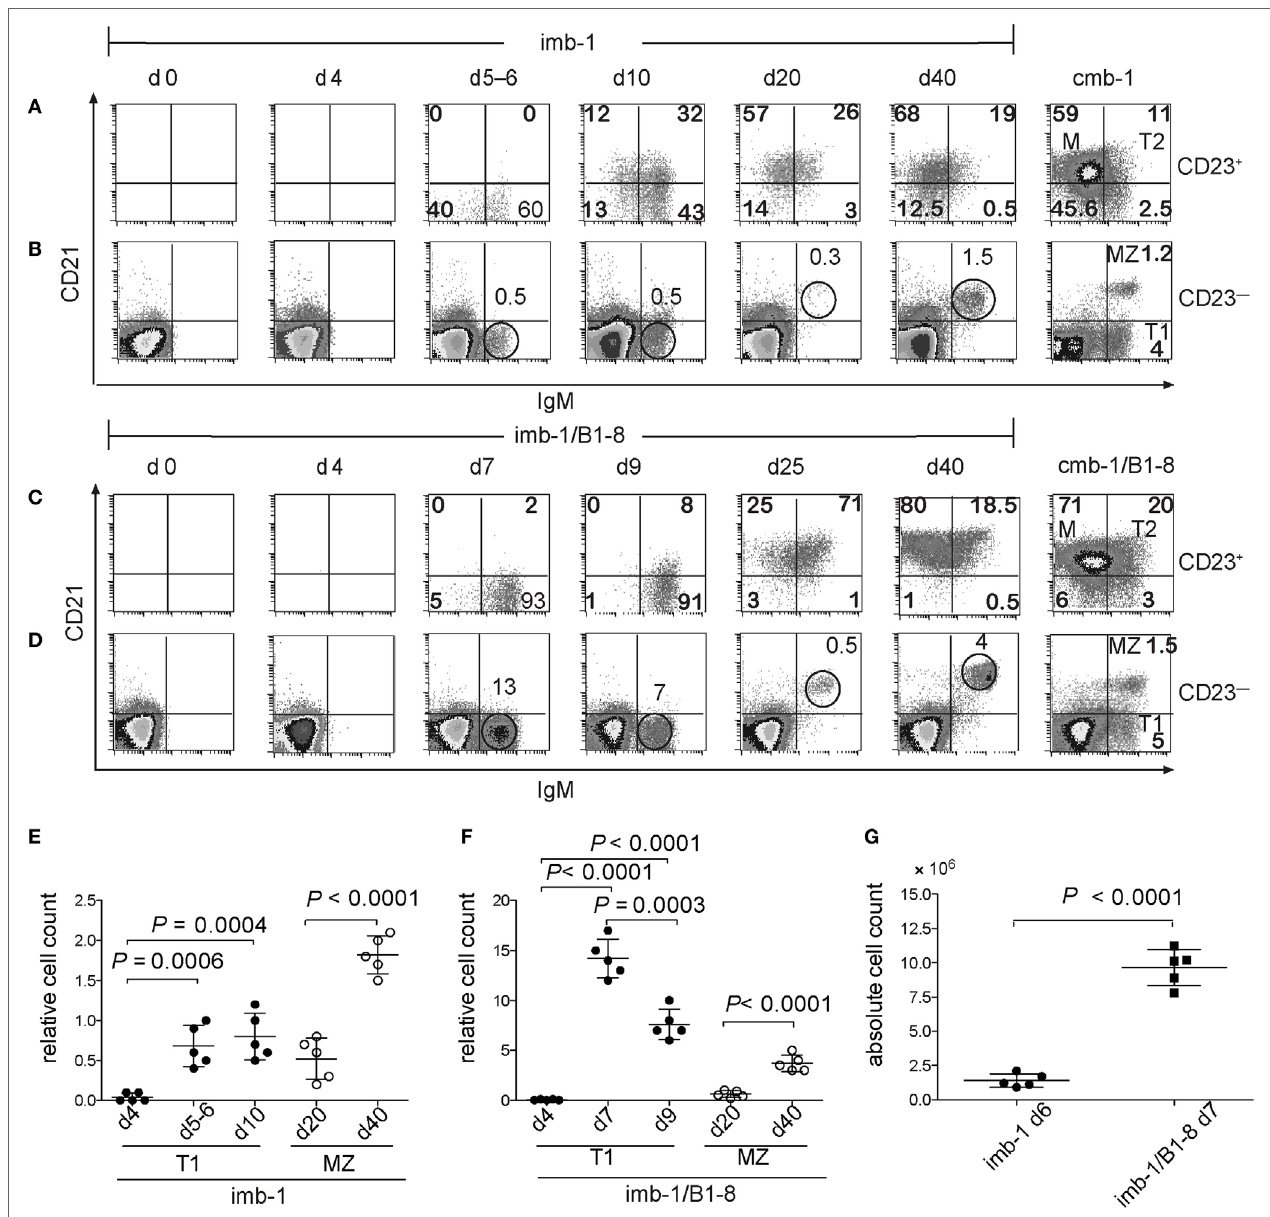
FigUre 3 | Transitional B cells express CD23 before CD21. (a) FACS analysis of CD21 and IgM expression on the CD23 + (a,c) and CD23 − (B,D) lymphocyte populations derived from the spleen of mice before (d0) or at indicated time points after a single treatment with tamoxifen. Cmb-1 and cmb-1/B1-8 mice with a constitutive B-cell development were analyzed in parallel. The percentages of the transitional 1 (T1) and marginal zone (MZ) populations within the CD23 − lymphoid gate at the designated time points post induction are indicated above the corresponding circle. Within the CD23 + lymphoid gate, the percentages of the transitional 2 (T2) and M populations are indicated within the upper quadrants. Representative data from two independent experiments with total five mice at each time point are shown. (e,F) Quantitative analysis of relative T1 and MZ-B cell numbers (percentage of cells within the CD23 − lymphoid gate) in imb-1 or imb-1/B1-8H mice at designated time points; mean ± SD of n = 5 is indicated for each time point; each dot represents an individual mouse; P values were determined using a two-tailed Student’s t -test and are indicated in the graphs. (g) Absolute B cell numbers in the spleens of imb-1 mice and imb-1/B1-8H mice at days 6 and 7, respectively; mean ± SD of n = 5 is indicated for each time point; each dot represents an individual mouse; P values were determined using a two-tailed Student’s t -test and are indicated in the